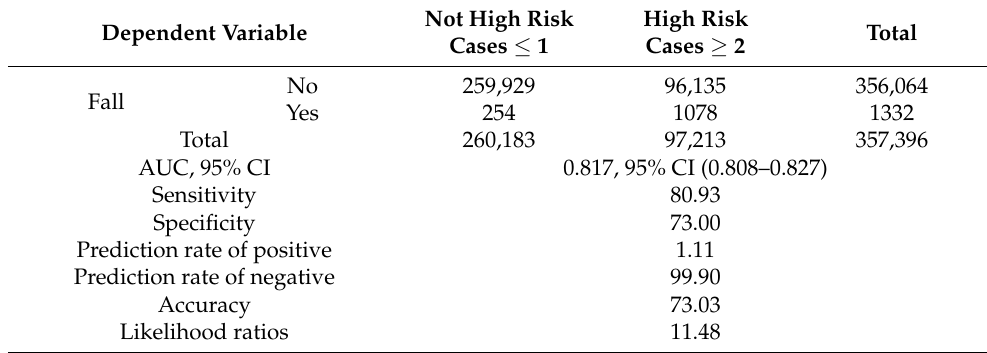
Figure 2. ROC Curve of New version fall risk assessment scale. Table 3. Accuracy Analysis of the best tangent point of the fall risk assessment scale. n =